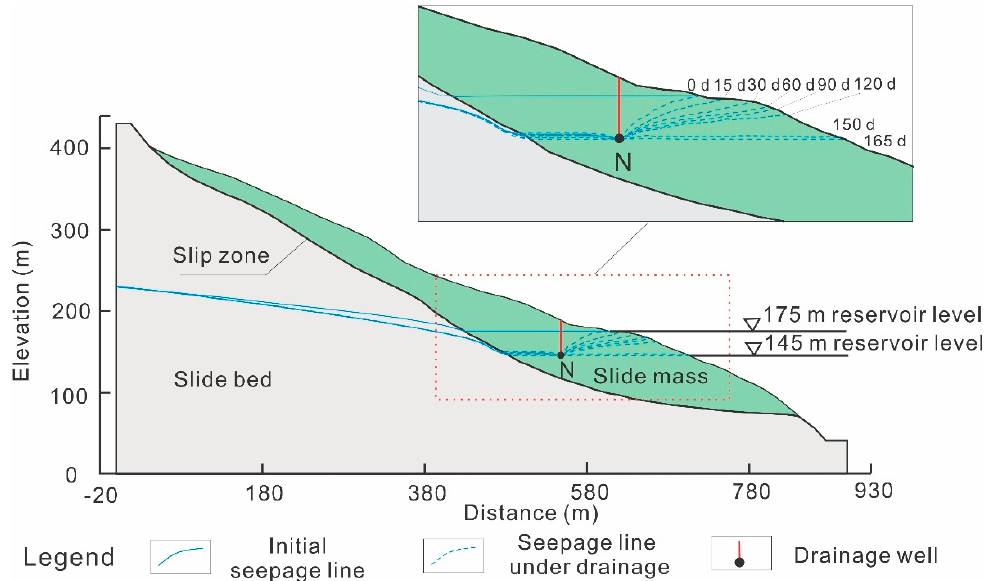
Figure 9. Phreatic lines in the process of reservoir level change combined with Drainage well N.